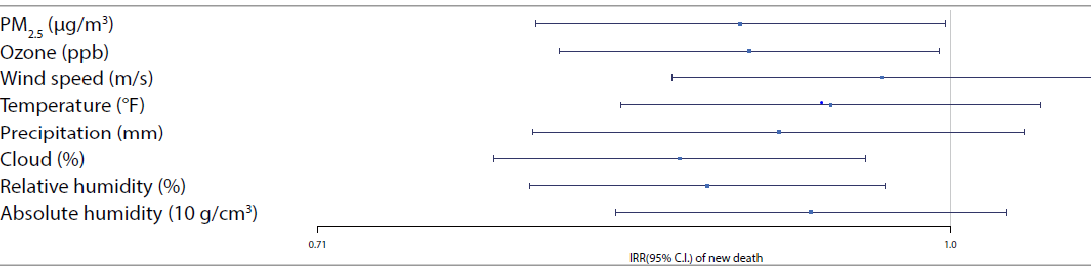
Figure 6. Trend and lag-case adjusted IRRs (and 95% CIs) associated with each environmental predictors for new COVID-19 related deaths.